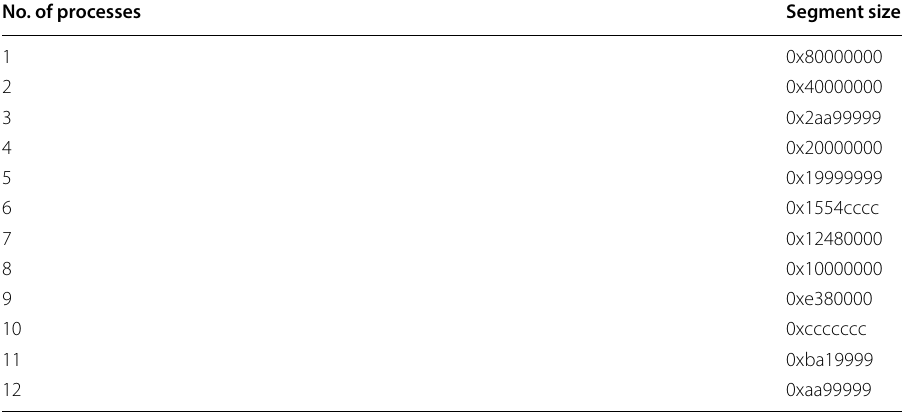
Table 2 The size of the segment based on the number of processes No. of processes